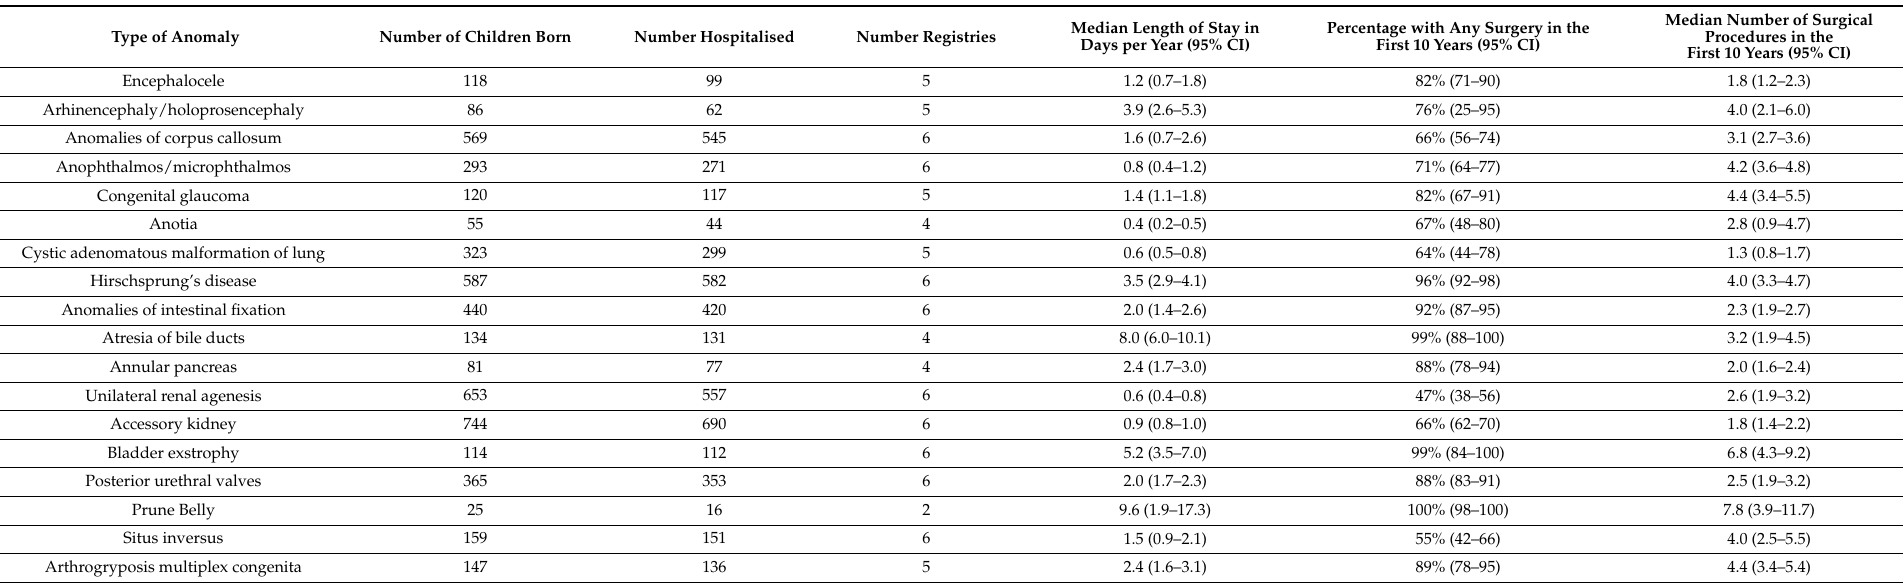
Table 3. Median length of stay and surgical procedures of children up to the age of 10 years for selected registries with follow-up of up to 10